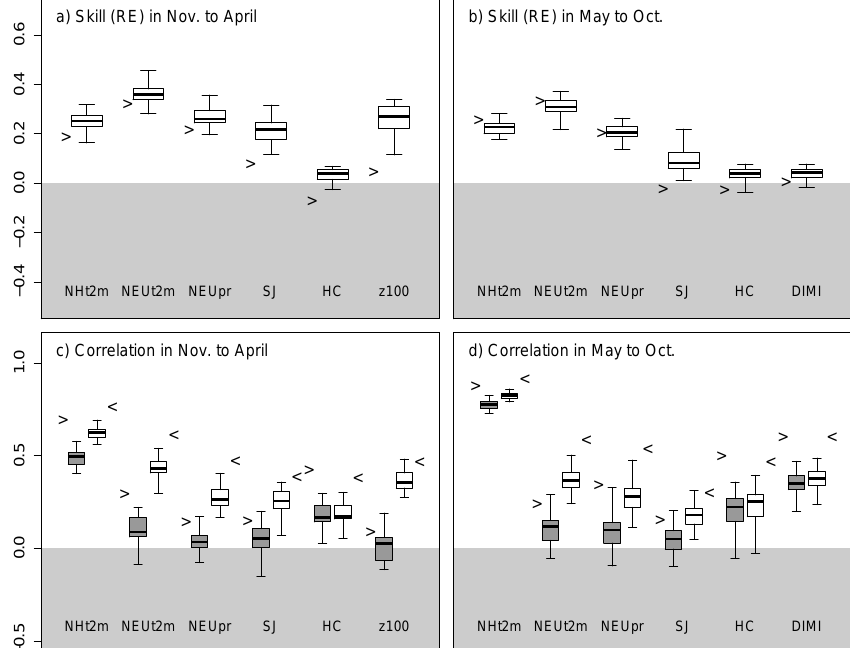
Fig. 6. Mean square error skill score (see Eq. 1) for boreal winter and summer in ( a ) and ( b ), and correlation for boreal winter and summer in ( c ) and ( d ) respectively for seven large-scale indicators. The indicators are Northern Hemispheric near-surface temperature over land (NHt2m), northern European temperature (NEUt2m) and precipitation (NEUpr) over land, the strength of the northern subtropical jet (SJ), the northern Hadley cell (HC), the stratospheric polar vortex (z100, boreal winter only), and the dynamic Indian monsoon index (DIMI, boreal summer only). Boxes indicate the interquartile range of skill scores (correlation) for the individual simulations, and the whiskers indicate the range of skill scores(correlation); the arrowheads indicate the skill scores (correlation) of the ensemble mean. In ( c ) and ( d ), the grey boxes and right-facing arrowheads indicate correlation between the unconstrained ensemble and the reference simulation; the white boxes and left-facing arrowheads are the correlation between the simulations after data assimilation and the reference simulation.